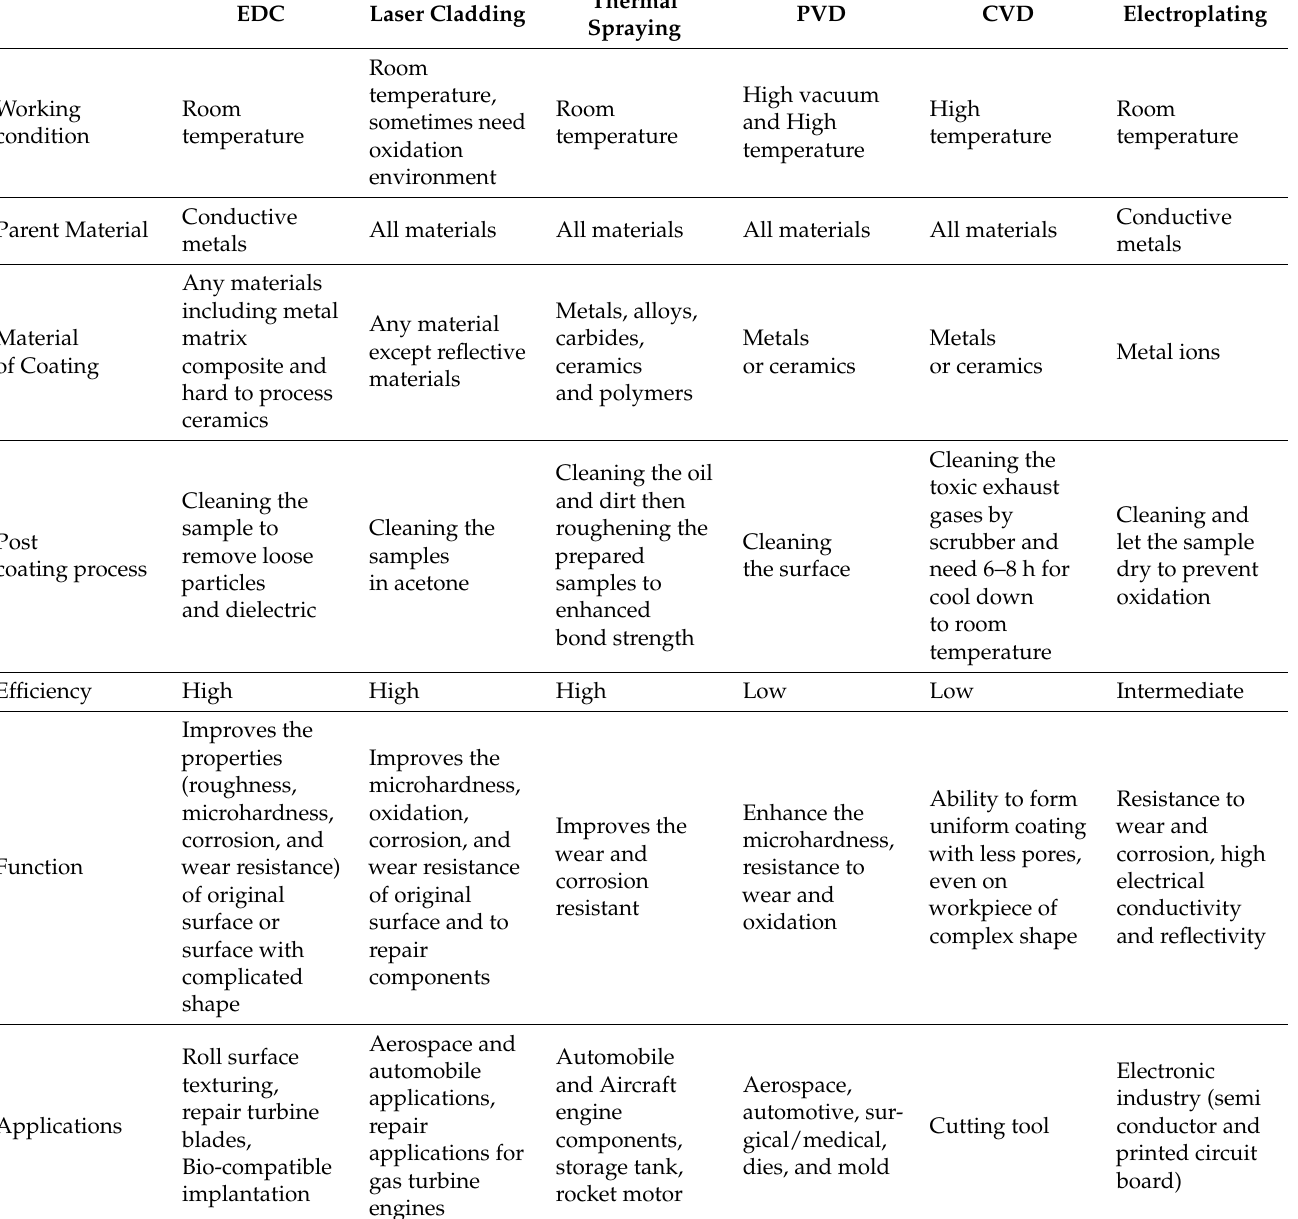
Table 1. Summary of comparison between EDC and other coating techniques